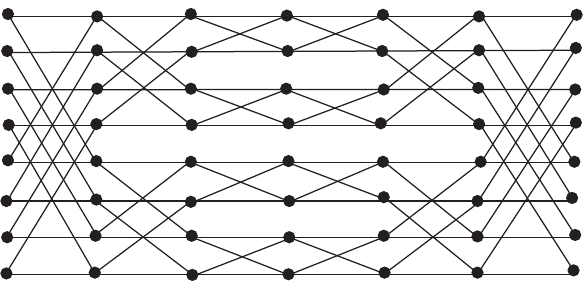
Figure 1: 3-dimensional Benes network.